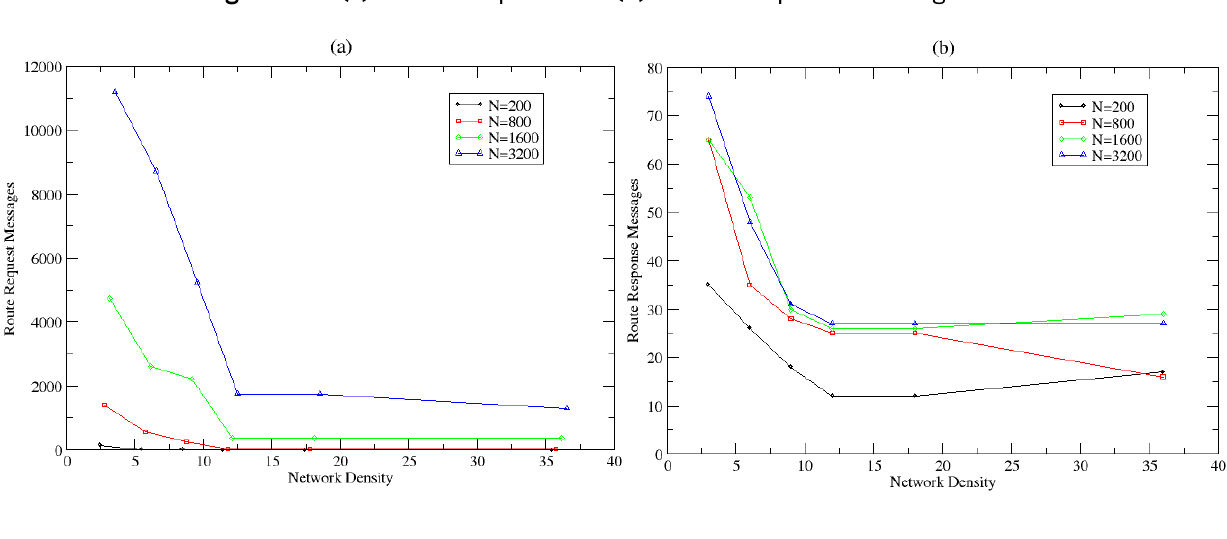
Figure 18. (a) Route Request and (b) Route Response Message